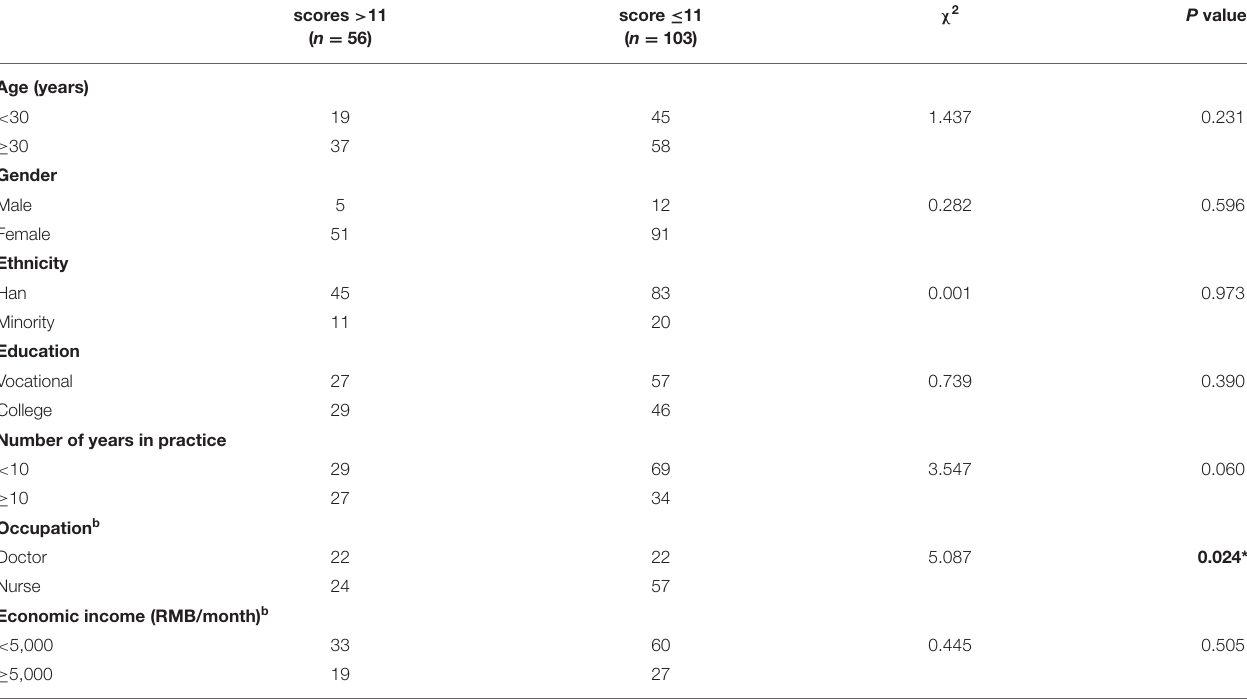
TABLE 7 | Univariate analysis of the groups with scores > 11 and ≤